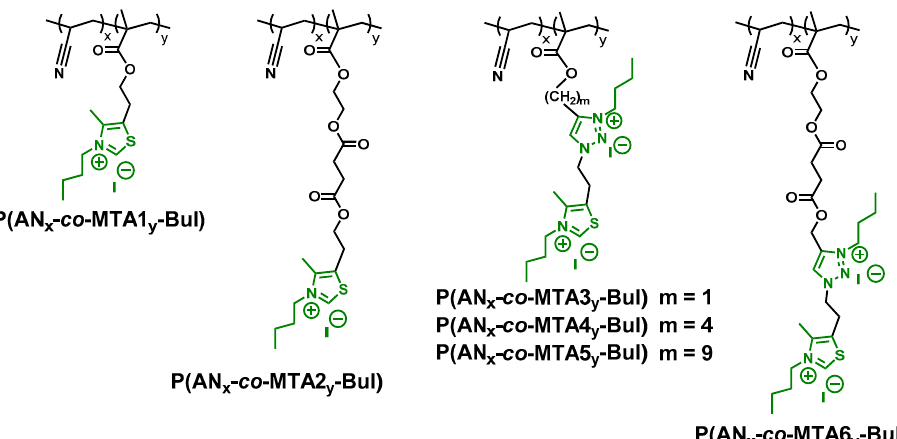
Figure 1. Quaternized copolymers of acrylonitrile and MTA# monomers.